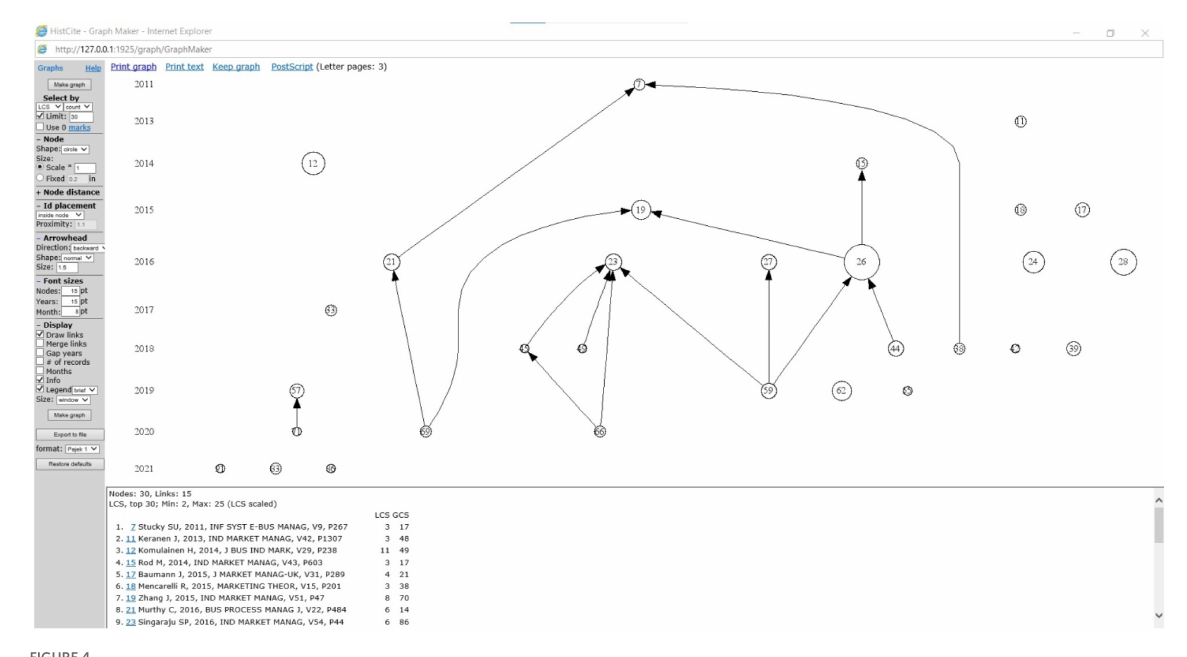
FIGURE4 HistCite citation mapping analysis. Reproduced with permission of Clarivate.